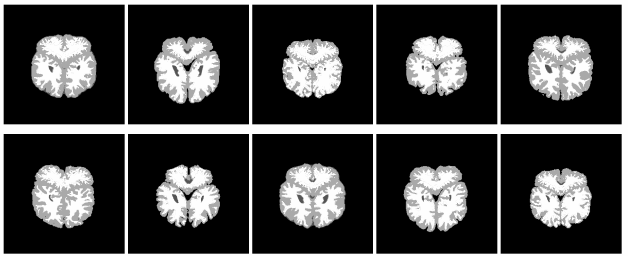
Figure 13. Obtained segmentations by the convex association of grouping functions.